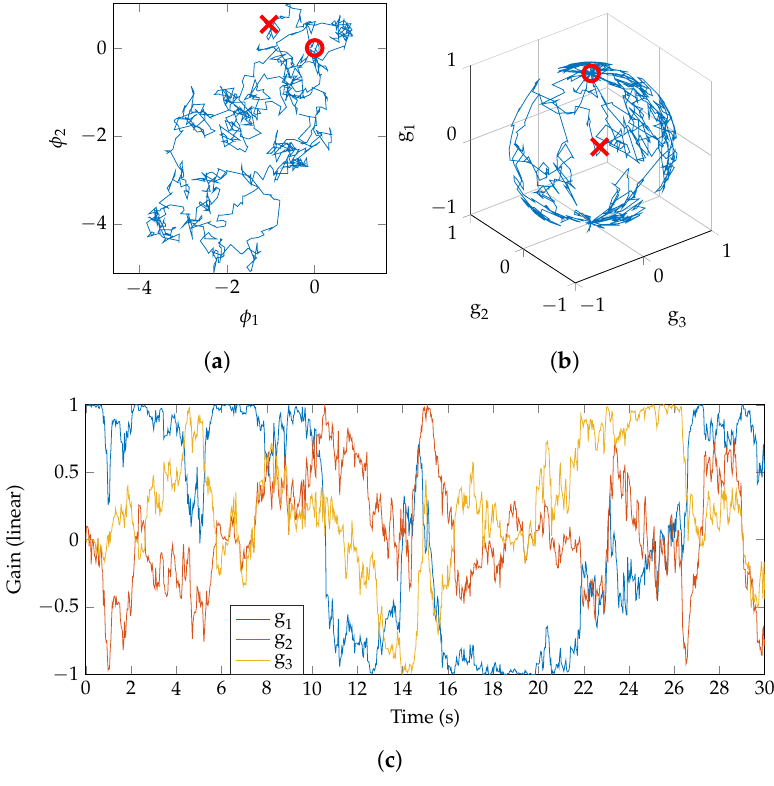
Figure 4. A time-varying mix can be considered as a path in the mix-space. Here, a random time-varying mix is generated by means of a random walk. ( a ) Random walk in mix-space; Brownian motion, halted after 30 s; ( b ) Random walk from Figure 4a converted to gain-space; ( c ) Time series of gain values for each of the three tracks.